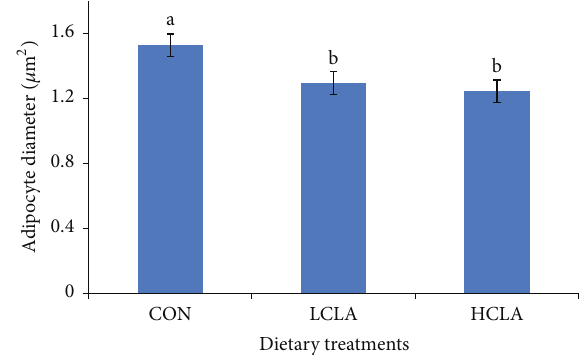
Figure 5: Effects of dietary conjugated linoleic acid (CLA) on adipocyte diameter in chickens fed with CON (control), LCLA (low conjugated linoleic acid), and HCLA (high conjugated linoleic acid) for 6 weeks. Data represent the mean of cell diameter. Data are presented as mean ± SEM. Different superscripts among bars denote significant differences ( 𝑃 < 0.05 ).